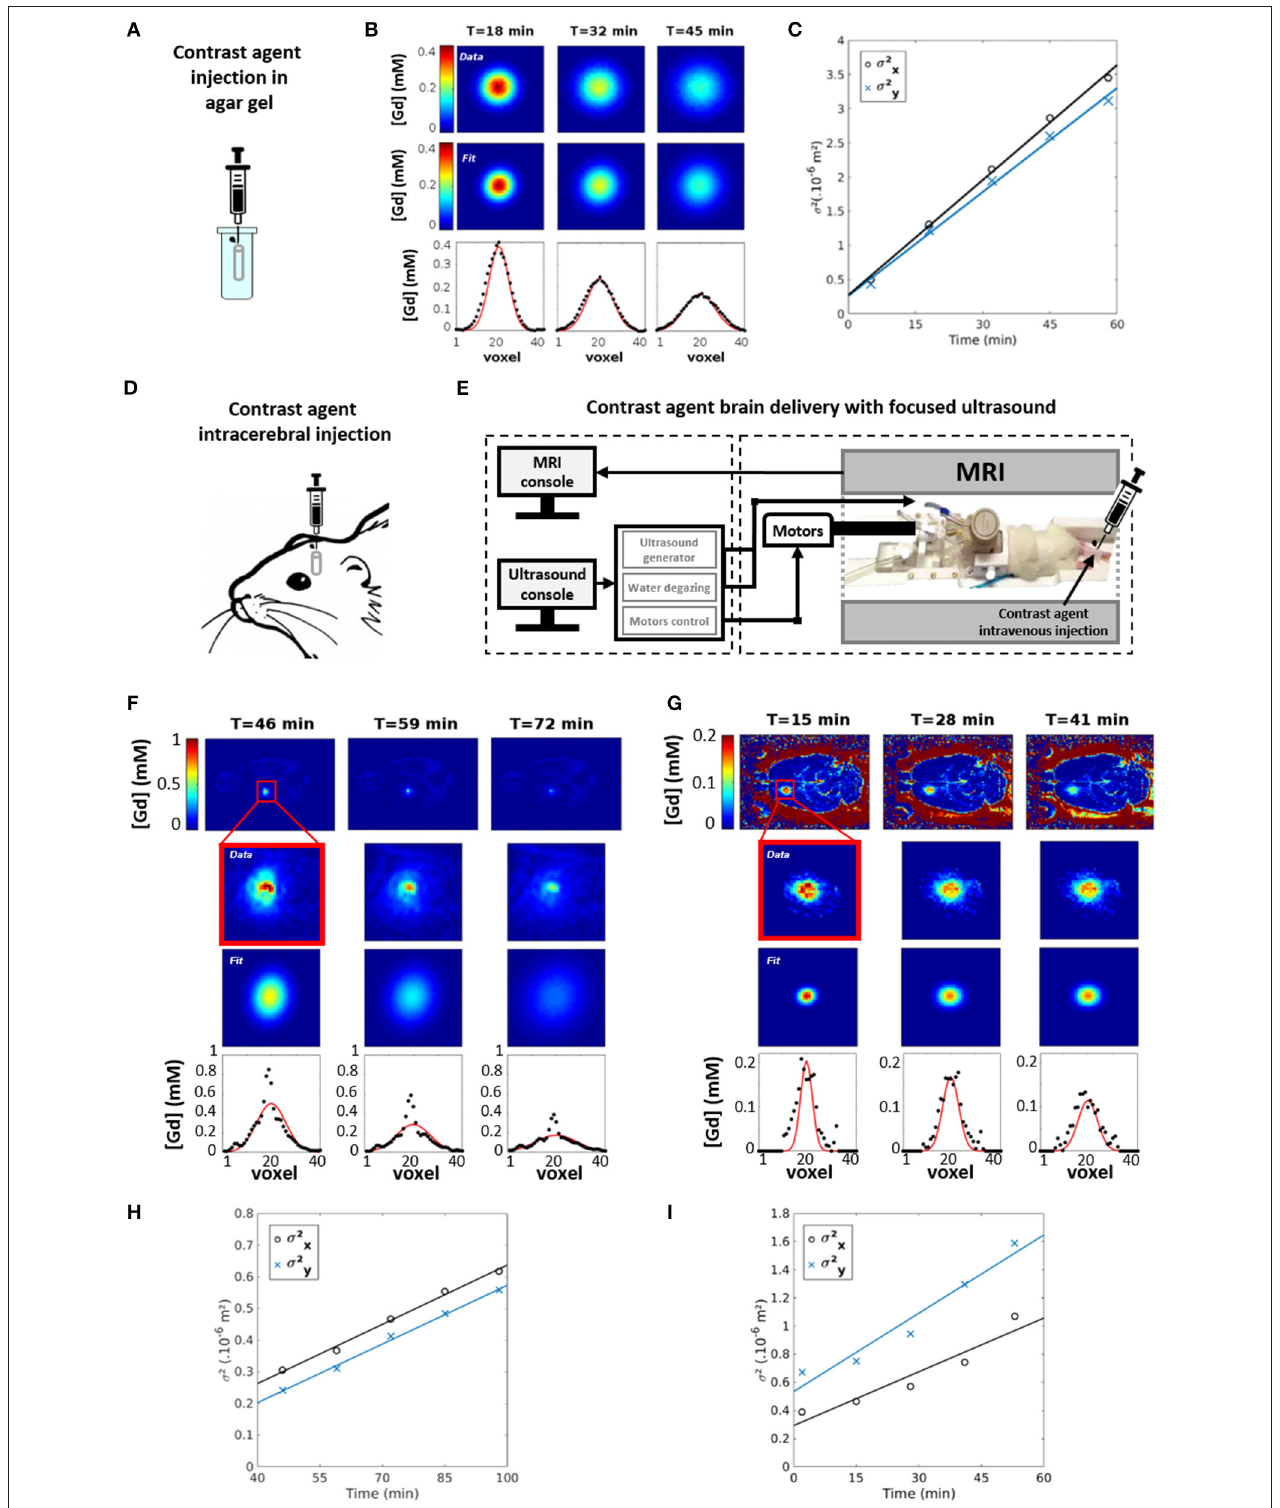
FIGURE 2 | MRI measurements of Gadolinium-based contrast agent diffusion. (A) The free diffusion coefficient D free of Dotarem ® is estimated by injecting a 5 µ L aliquot with a Hamilton syringe in a tube filled with dilute agar gel (0.3% w/w) maintained at 37 ◦ C. (B) Concentration maps of Dotarem ® (upper row) are acquired